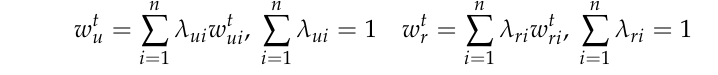
Table 1. Details of the urban water risk components, indicators, and